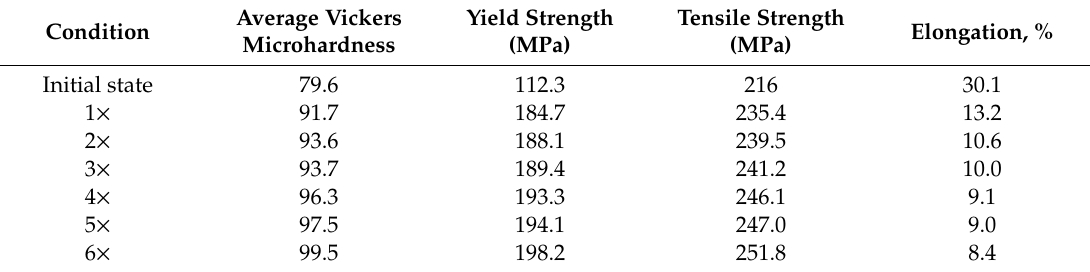
Figure 7. Hardness distribution along the sheet thickness of the 5754 aluminum alloy samples. Table 4. Summary of mechanical properties of 5754